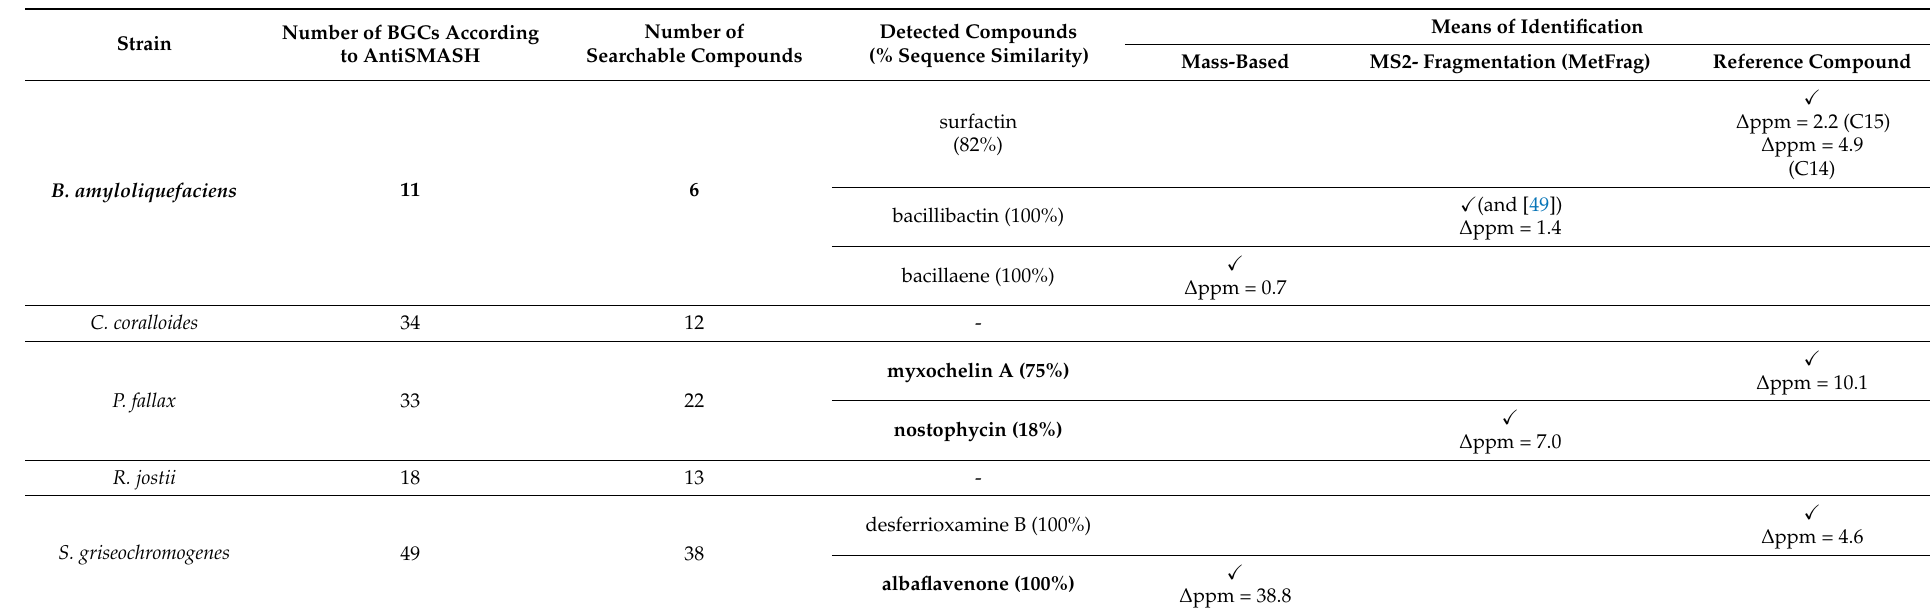
Table 4. Summary of detected compounds from the number of searchable compounds based on the predicted non-orphan BGCs in the five selected bacteria. These compounds were identified in the analyzed extracts of the bacteria. Mass-based identification was carried out with the extracted ion chromatogram (EIC) function of the Compass Data Analysis software with 0.01 Da tolerance and under consideration of the isotopic profile. Deviations of the measured m / z from the calculated [M + H] + in ppm are indicated in the table. A comparison of experimental MS2-spectra with in silico fragmentation patterns generated via MetFrag was used for bacillibactin and nostophycin. Additionally, the fragmentation pattern of bacillibactin was compared to literature data [49]. Compounds in bold were only found in extracts of OSMAC experiments, but not in the control group. The producing conditions for each compound can be taken from Table S19. Control group means the cultivation of the bacteria in their DSMZ-recommended, nutrient-rich media (NB medium for B. amyloliquefaciens , SP medium